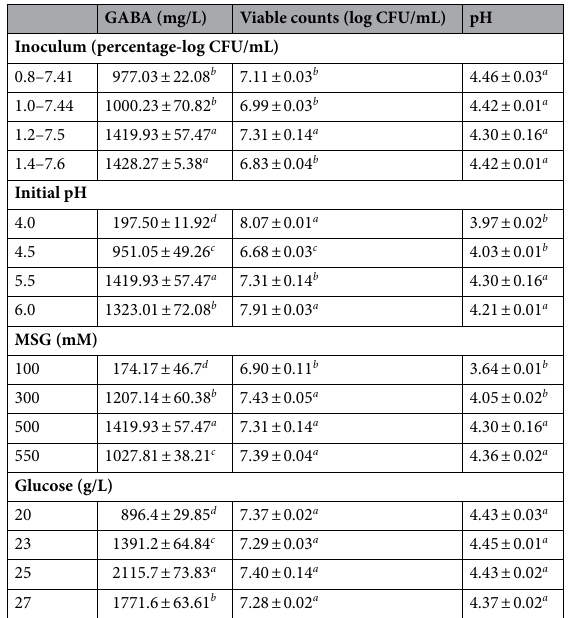
Table 2. GABA (mg/L), viable counts (log CFU/mL) and pH values obtained with Lactiplantibacillus plantarum K16 in MRS broth, after 96 h of fermentation, using different percentages of inoculum, initial pH, MSG, and glucose concentration (Different letter superscripts indicate if the results are statistically significant ( P ≤ 0.05) in the GABA, viable counts or pH values among the levels of each fermentation